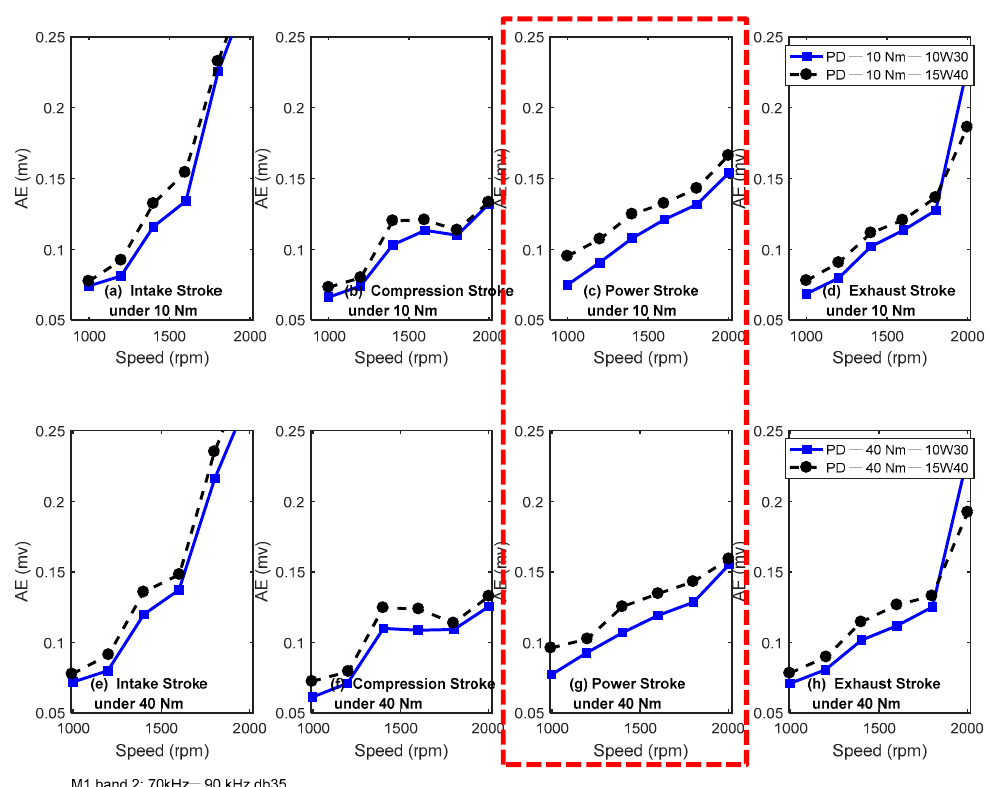
Figure 8. AE indicators from 70 kHz to 90 kHz for four strokes under different operating conditions.